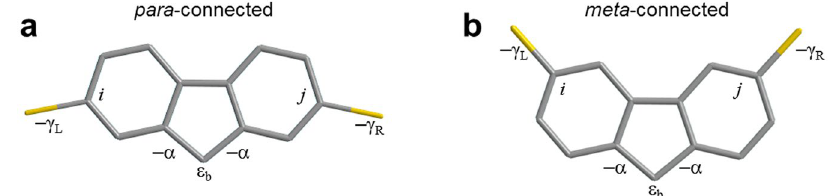
Figure 4. Tight-binding (i.e. Hückel) models of para -( a ) and meta -connected ( b ) molecules. Within the core of each, all site energies are zero except the pendant site energy ɛ b and all nearest neighbour bonds are equal to − 1, except for those denoted as α . The weaker couplings between the molecule and left leads are − γ atom number i and right leads − γ R = − 0.08 at atom number j .